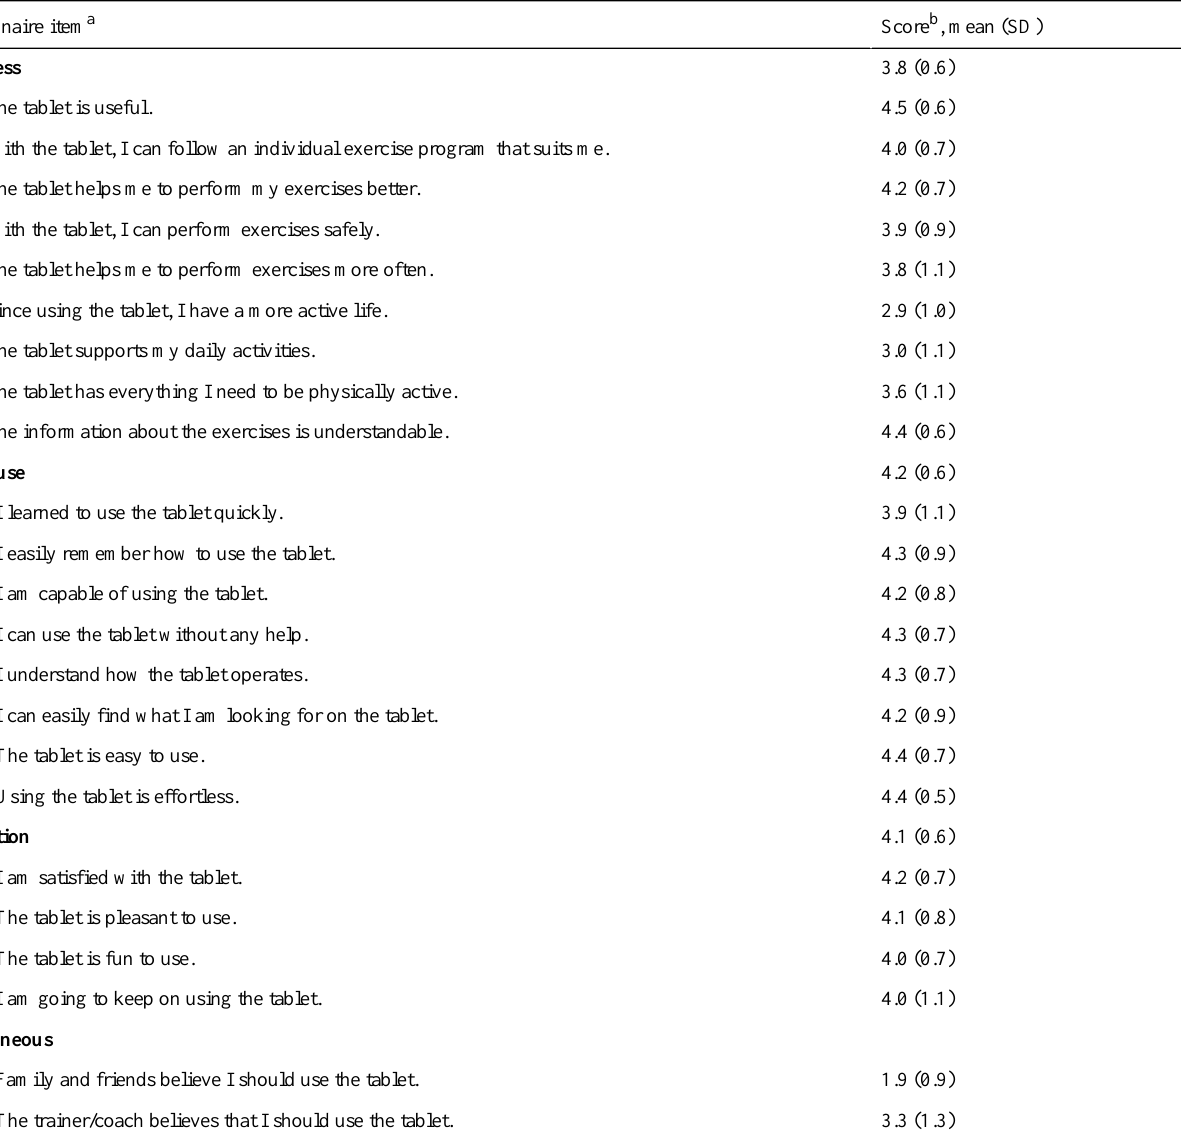
Table 2. Scores of usefulness, ease of use, and satisfaction items (5-point Likert scale)